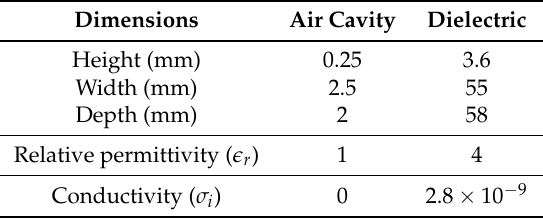
Table 1. Characteristics of the air cavity.